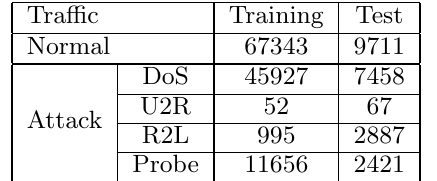
Table 1: Traffic records distribution in the training and test data for normal and attack traffic